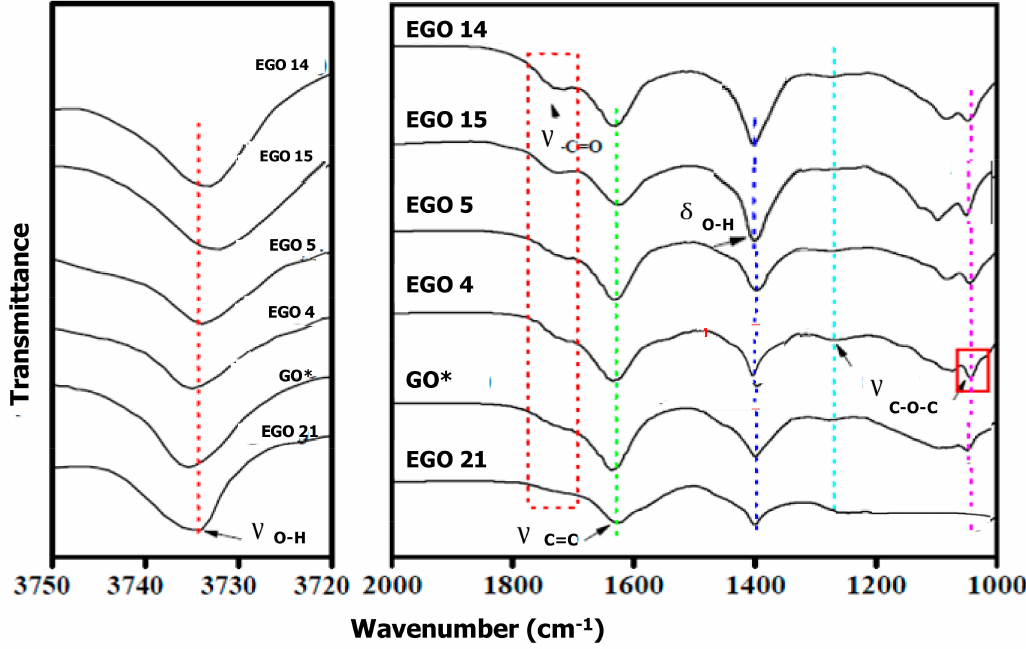
Figure 4. FT-IR spectra of the reference (GO*) and the indicated EGO